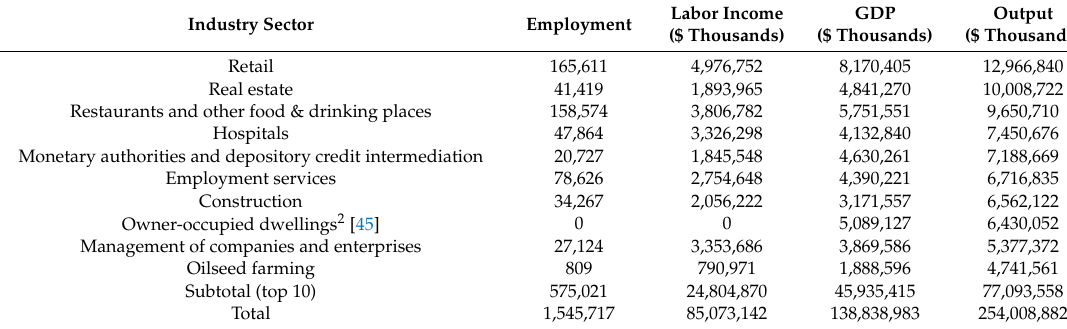
Table 8. Top 10 Most A ff ected Sectors by